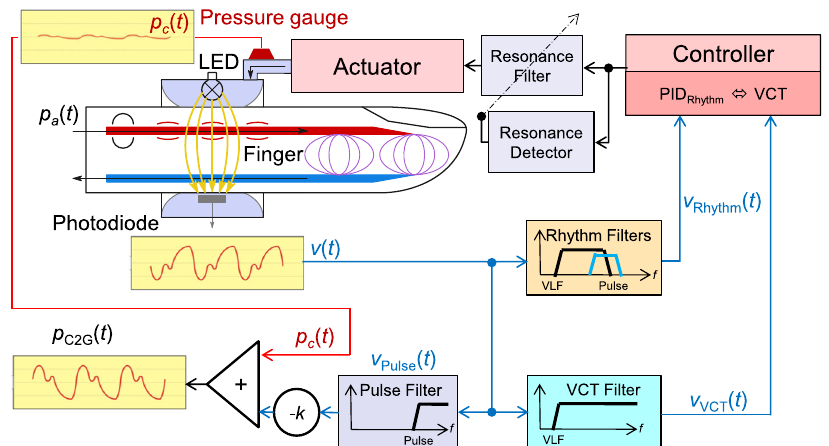
Fig. 2 Block diagram and signal fl ow of CNAP2GO. An LED-light is directed through a fi nger and its absorption is measured by a photodiode depending on arterial pressure p a ( t ). The resulting photo-plethysmographic signal v(t) is led into digital fi lters producing v Pulse ( t ), v Rhythm ( t ), and v VCT ( t ). Signal components v Rhythm ( t ) and v VCT ( t ) are used to control the pressure p c ( t ), whereas v Pulse ( t ) together with p c ( t ) are needed for the calculation of the pulsatile blood pressure signal p C2G ( t ). The control loop using a proportional-integral-differential controller PID Rhythm and the volume control technique (VCT) is closed using antiresonance elements. f: frequency, VLF: very low-frequency cutoff, k: ampli fi cation factor.